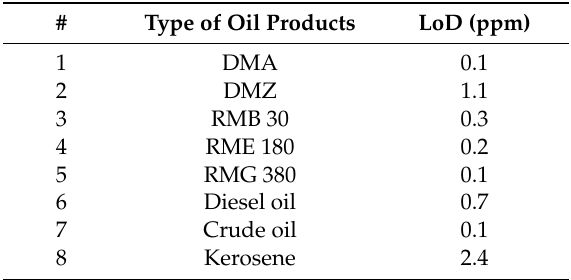
Table 1. Limit of detection (LoD) values for the various oil products.